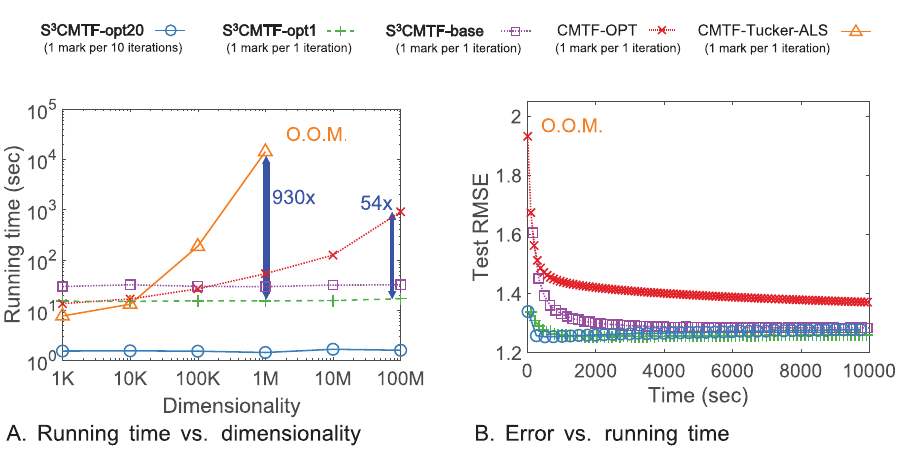
Fig 1. Comparison of our proposed S 3 CMTF and the existing methods. (a) For a fixed number of nonzeros, S 3 CMTF takes constant time as dimensionality grows, while existing methods become slower. Our sequential method S 3 CMTF-opt1 is 930 × and 54 × faster than CMTF-OPT and CMTF-Tucker ALS, respectively. (b) S 3 CMTF-opt20 shows the best convergence rate and accuracy on real world Yelp dataset. CMTF-Tucker-ALS shows O.O.M. in both experiments. (O.O.M.: out of memory